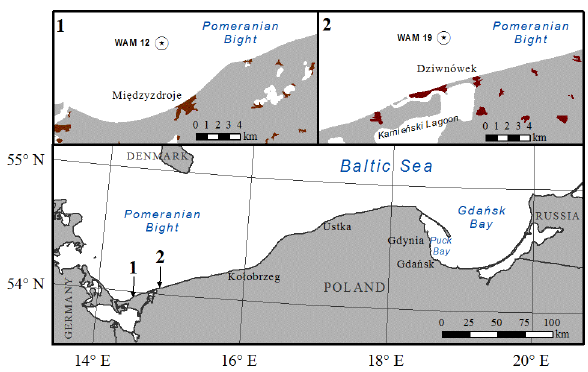
Figure 1. Polish Baltic Sea coast. Location of the test sites in Mie˛dzyzdroje (1) and Dziwno´wek (2) is marked.